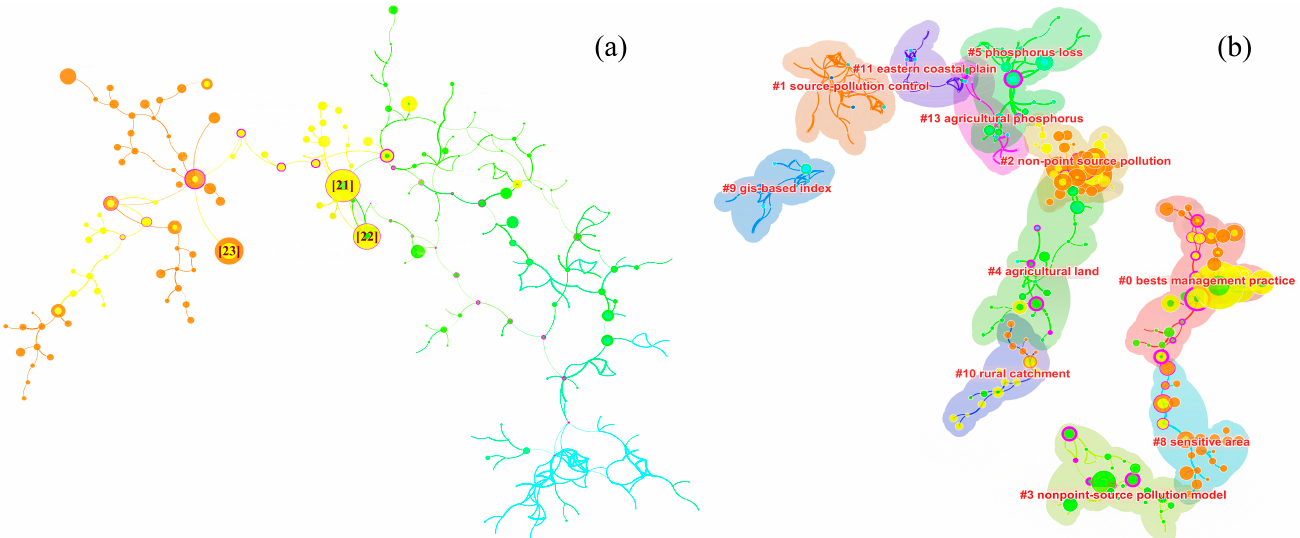
Figure 2. Co-citation network ( a ) and cluster analysis of papers [21–23] ( b ) from WoS. Note: The node represents the citation, and the size of the node is in direct proportion to the frequency of the citation. The appearance of purple in the outer circle of the node indicates that the citation has a high centrality. The color of different cluster groups is random, and the lines are the same color.